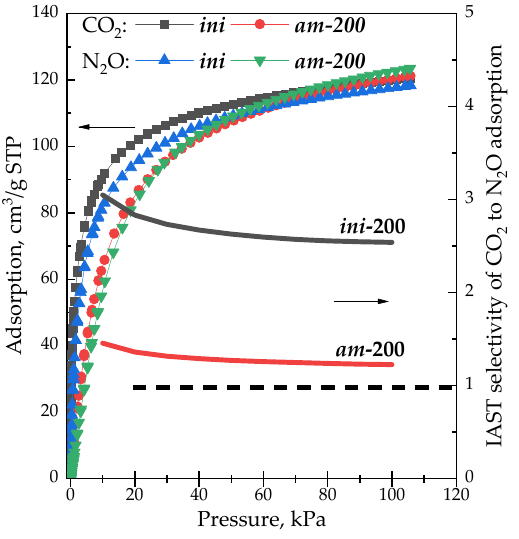
Figure 10. Influence of Si/Al ratio on: ( a ) PA (kJ/mol) of BASs [110–112]; ( b ) BAS concentration (µmol/g) [22,27,113–117]. Asterisks designate data from this work. High PA, compared to Y zeolites, accompanied with low BAS concentration and relatively low hydrothermal stability of H-LSX do not allow for the consideration of this material as a prospective catalyst. However, extra-framework protons and ammonia cations definitely rearrange surface charges. This is manifested in the adsorption of polar molecules. Figure 11 shows adsorption isotherms of pure CO 2 and N 2 O at 0 °C and the corresponding adsorption selectivity (S N2O/CO2 ) for samples ini -200 and am -200 within the range of pressure ~0–100 kPa. The selectivity was calculated by means of IAST++ software in assumption of a 50/50 v / v gas mixture composition.